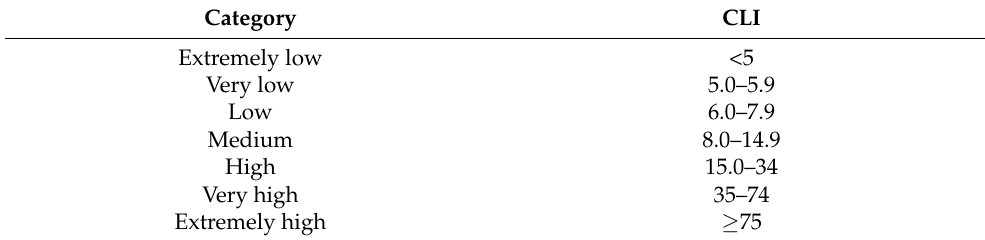
Table 2. Category of intervals for drillability indices [24].